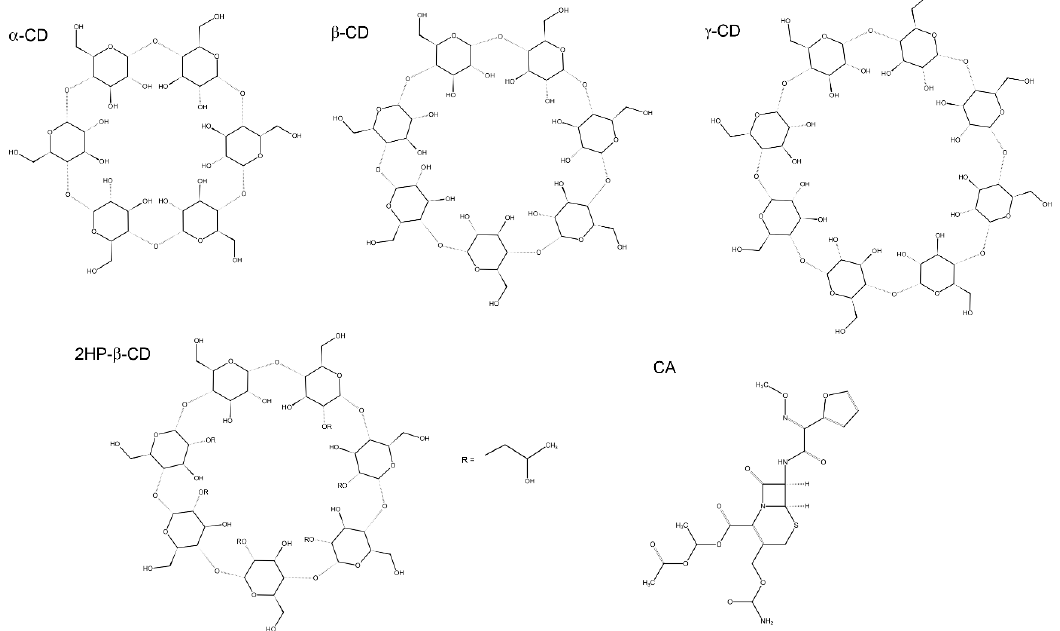
Figure 1. Chemical structures of cefuroxime axetil (CA) and the most common natural cyclodextrins: α-, β-, and γ-CDs as well as 2-hydroxypropyl-β-cyclodextrin (2HP-β-CD). The functionalization pattern of 2HP-β-CD was accepted according to the compound used in the present study.